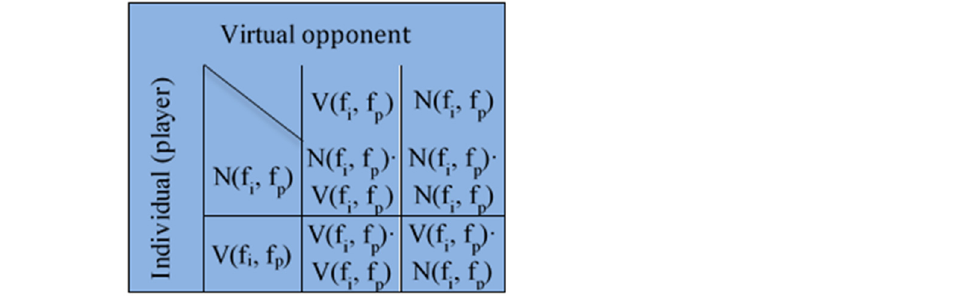
Figure 3. The payoff matrix in the vaccination game. V designates vaccination payoff, N designates anti-vaccination payoff.